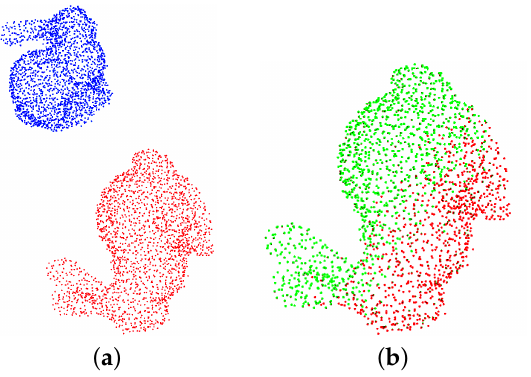
Figure 1. Point cloud registration with TIF-Reg. ( a ) The input point clouds. ( b ) The registered point clouds. The relative rotation of [ x , y , z ] is [ 77.4 ◦ , − 129.5 ◦ , 17.5 ◦ ] and the relative translation of [ x , y , z ] is [ 2.9 m, − 1.0 m, − 2.5 m ]